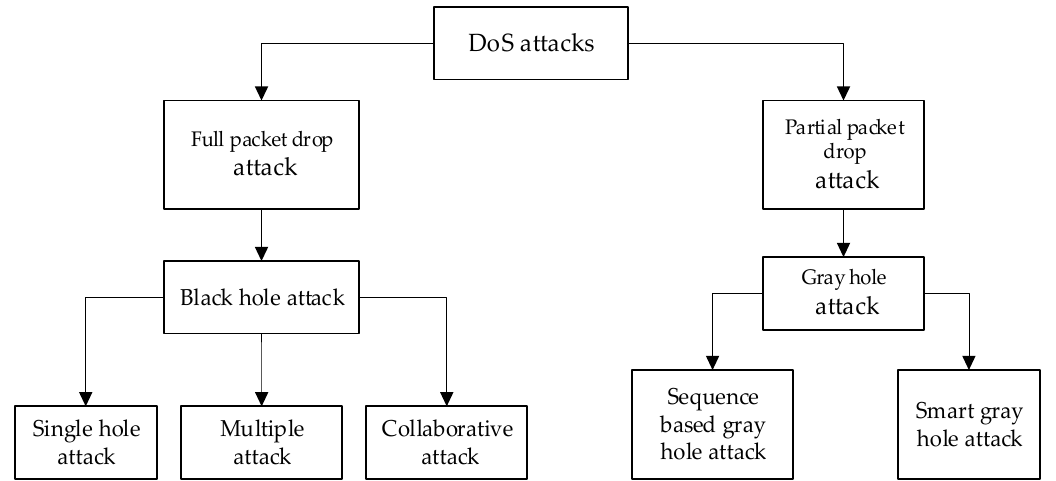
Figure 1. Classification of Denial of Service (DoS) attacks.